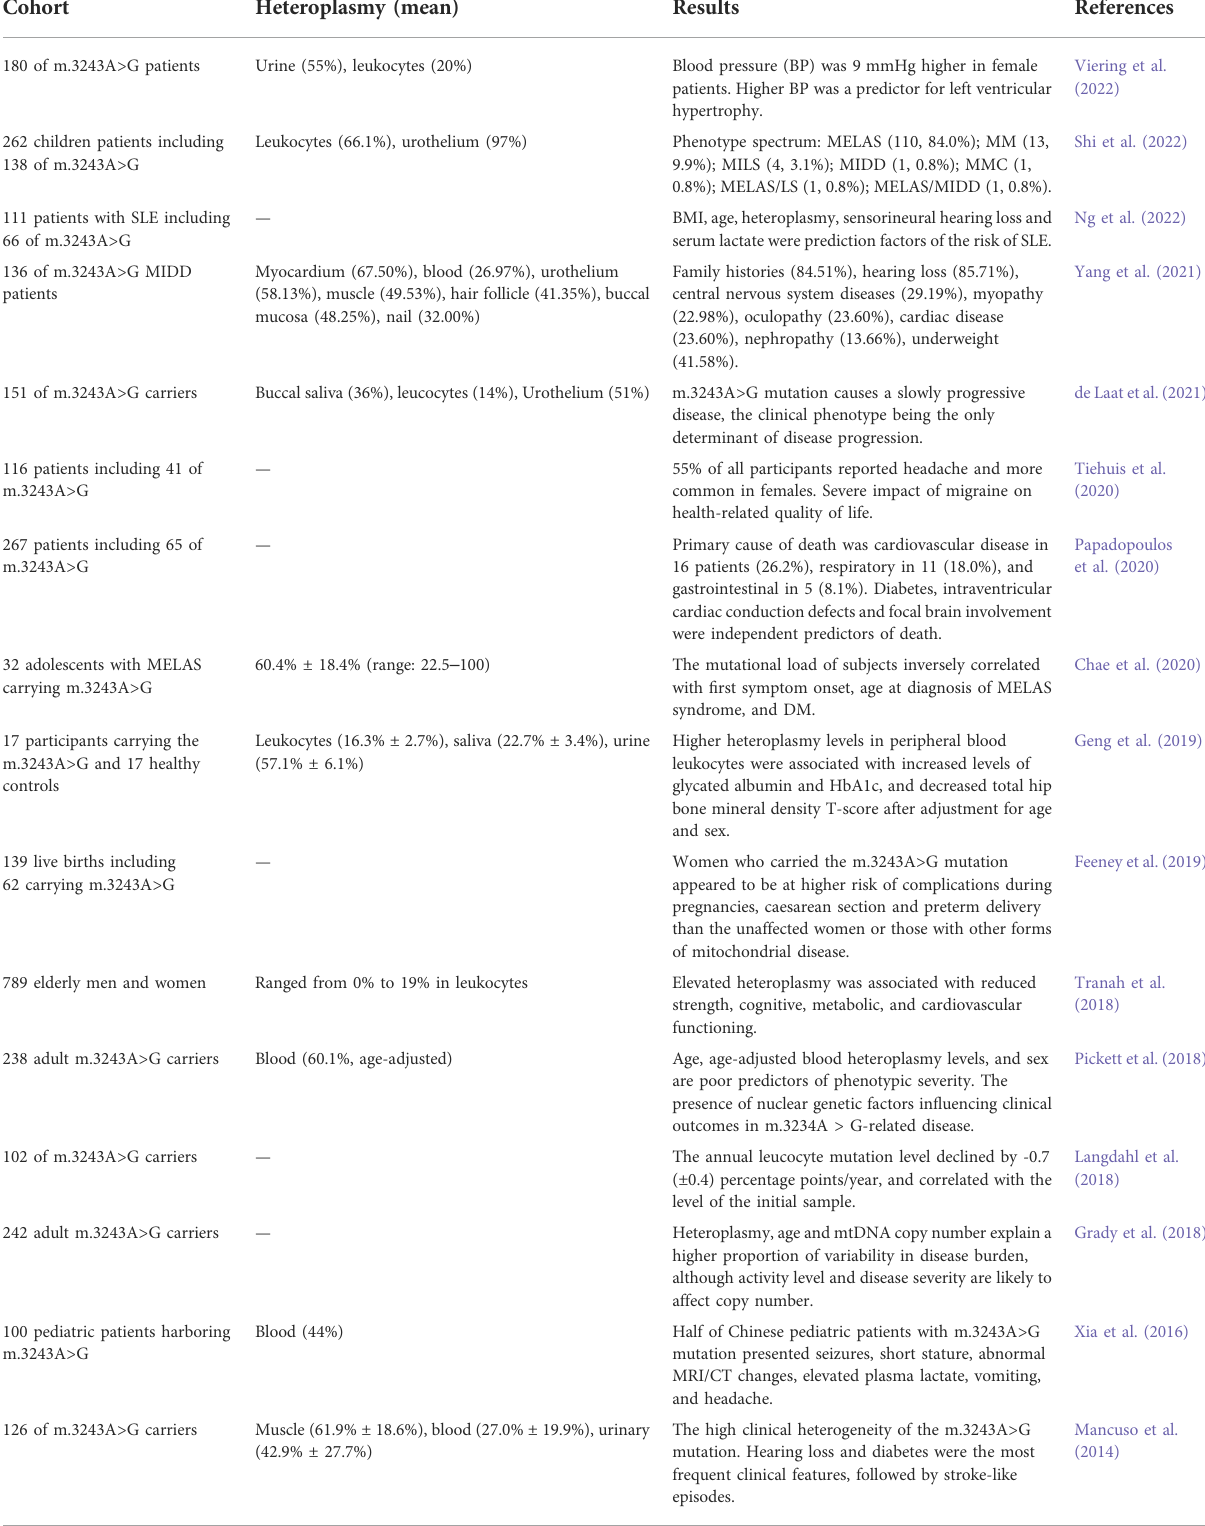
TABLE 1 The results of recent large cohorts relating m.3243A > G